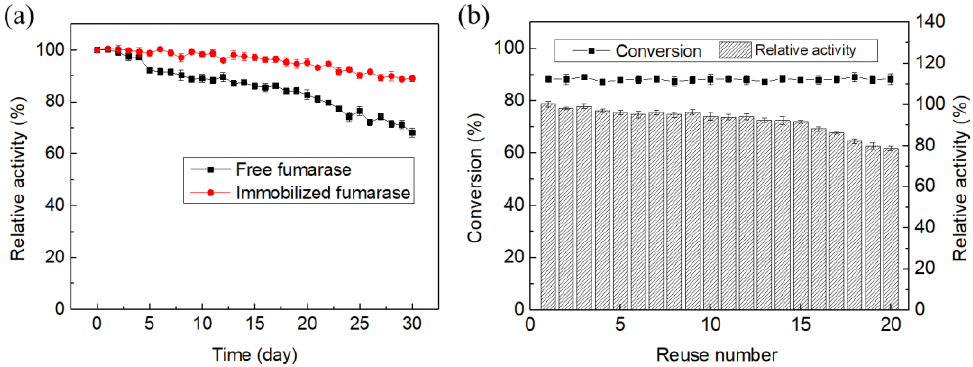
Figure 7. Storage ( a ) and recyclability ( b ) of immobilized and free fumarase.